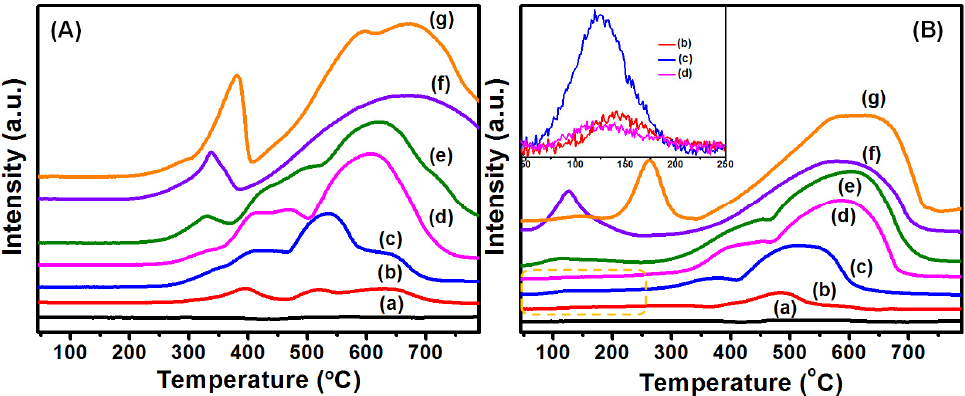
Figure 2. ( A ) H 2 ‐ TPR profiles of (a) ZnO, (b) Zn 0.9 Fe 0.1 O x , (c) Zn 0.7 Fe 0.3 O x , (d) Zn 0.5 Fe 0.5 O x , (e) Zn 0.3 Fe 0.7 O x , (f) Zn 0.1 Fe 0.9 O x , and (g) Fe 2 O 3 ; ( B ) H 2 ‐ TPR profiles of (a) Au/ZnO, (b) Au/Zn 0.9 Fe 0.1 O x , (c) Au/Zn 0.7 Fe 0.3 O x , (d) Au/Zn 0.5 Fe 0.5 O x , (e) Au/Zn 0.3 Fe 0.7 O x , (f) Au/Zn 0.1 Fe 0.9 O x , and (g) Au/Fe 2 O 3 . The enlarged H 2 ‐ TPR profiles of (b) Au/Zn 0.9 Fe 0.1 O x , (c) Au/Zn 0.7 Fe 0.3 O x , (d) Au/Zn 0.5 Fe 0.5 O x from 50 to 250 °C subtracted the